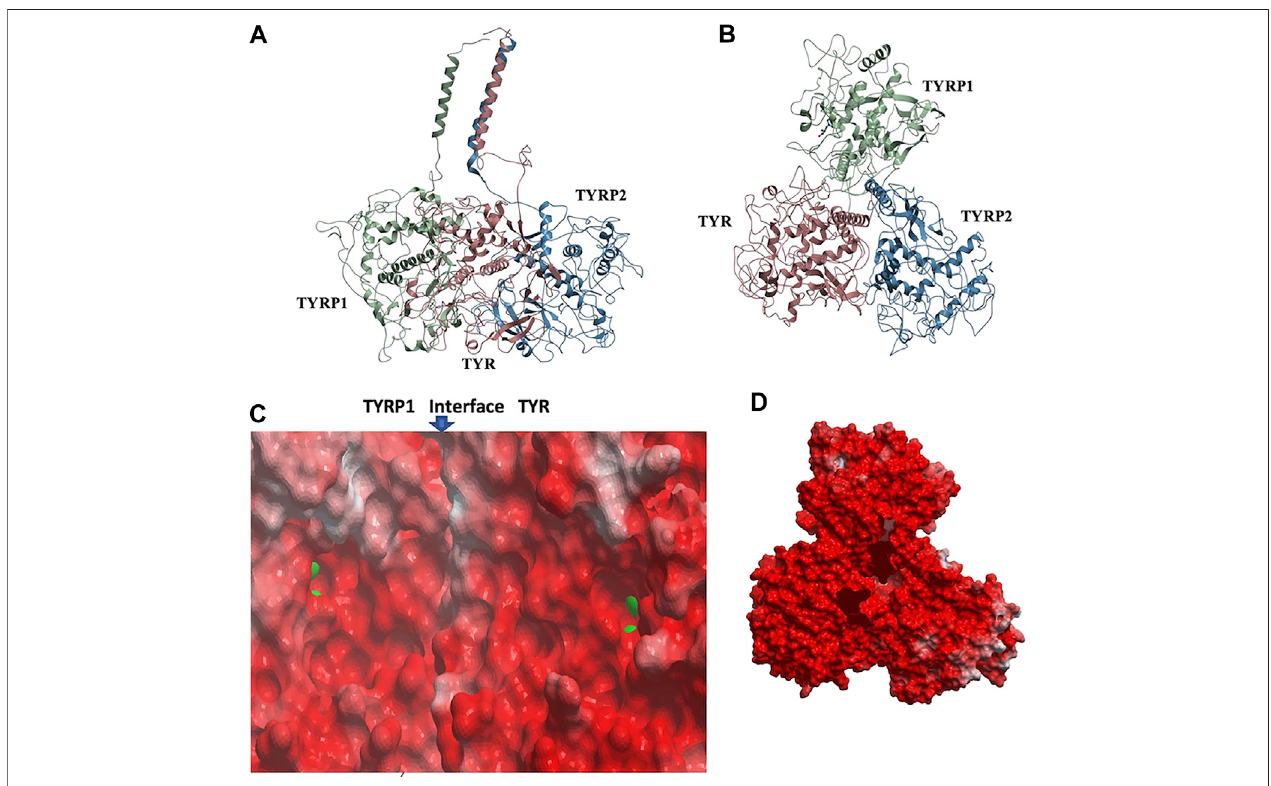
FIGURE 4 | TYR-TYRP1-TYRP2 heterotrimeric complex. (A) . Side view, highlighting compatibility of the docked locations of the three N-terminii and their linker lengths between intramelanosomal domains and N-terminal TM-helices with formation of three-helix TM bundle. (B) . Top view. (C) . Electrostatic surfaces of the TYR- TYRP1interfaceisshown,revealingcontinuityofactivesitesofTYRandTYRP1inheterotimer(zincionsaregreenspheresmarkingactivesites) (D). Electrostaticsurface of heterotrimer surface facing the membrane (red (cid:1) electronegative/acidic, blue (cid:1)